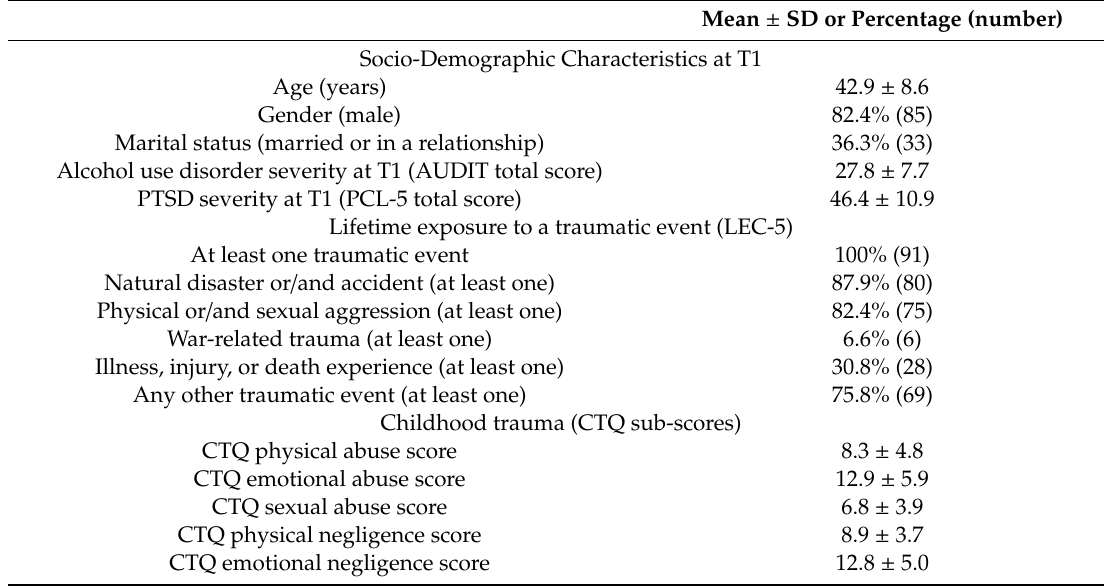
Table 1. Descriptive statistics of the sample at baseline (T1; n =